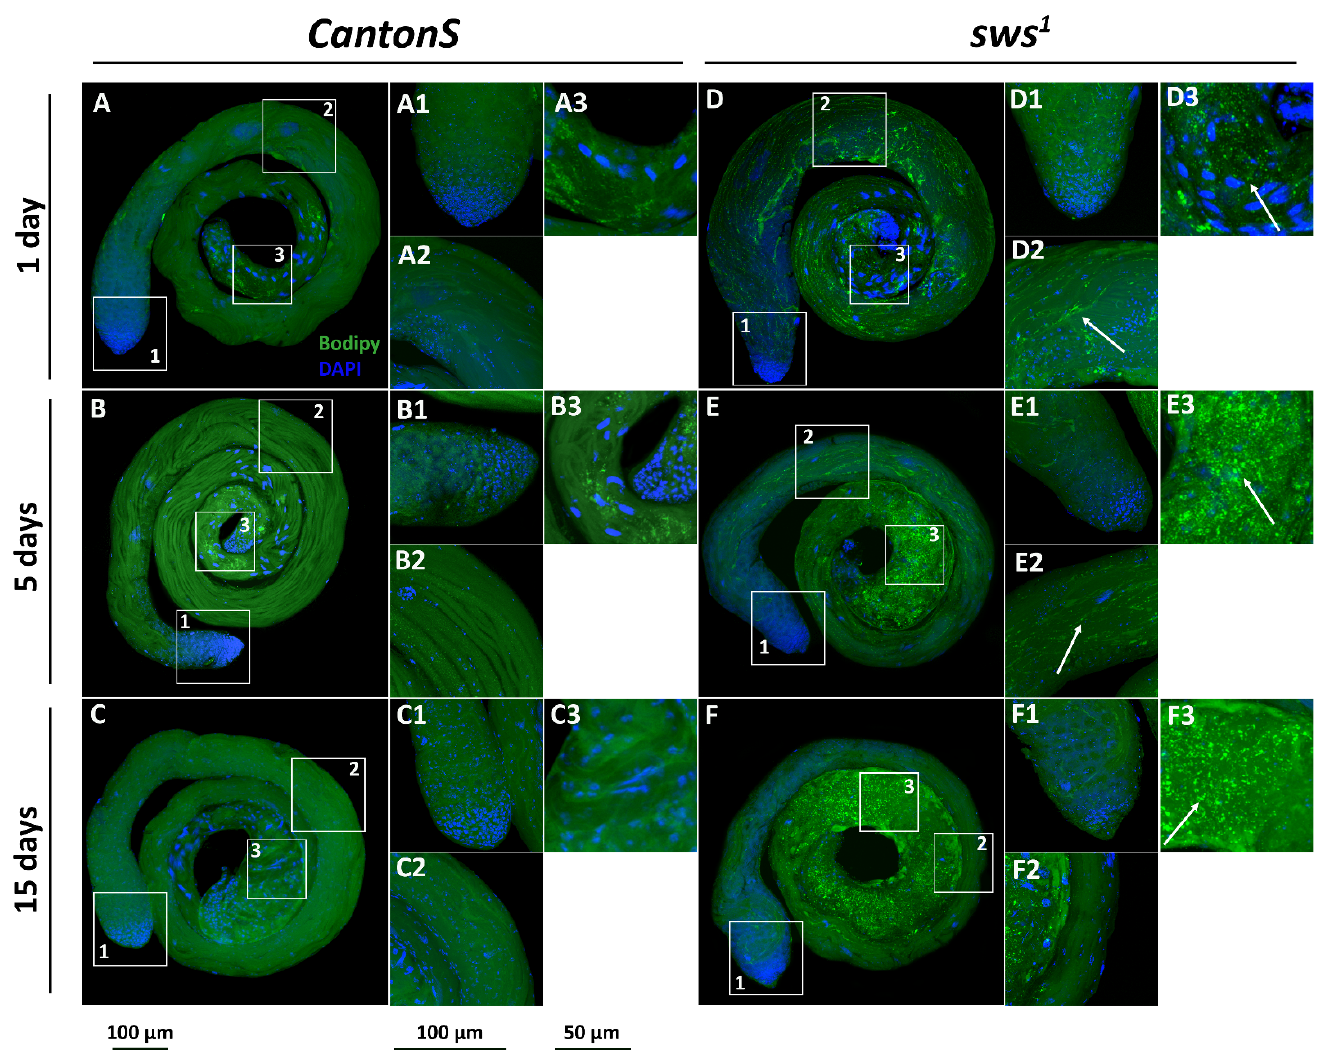
Figure 8. Lipid droplet analysis. 3D confocal stacks of testes stained with BODIPY 493/503 (green), showing the distribution of neutral lipids in CantonS ( A – C ) and sws 1 ( D – F ) males of different ages. Areas in white boxes were scanned additionally to obtain magnifications of ( 1 ) apical tip, ( 2 ) middle zone, and ( 3 ) proximal region. Lipid droplets are bright green dots (marked with arrows). Nuclei are stained with DAPI (blue). Scale bar is written under columns: 100 µm (whole images designated with letters; magnifications ( 1 , 2 )), 50 µm (magnifications ( 3 )). Note that there are few LDs in control testes, but LDs are abundant in sws 1 mutant testes.